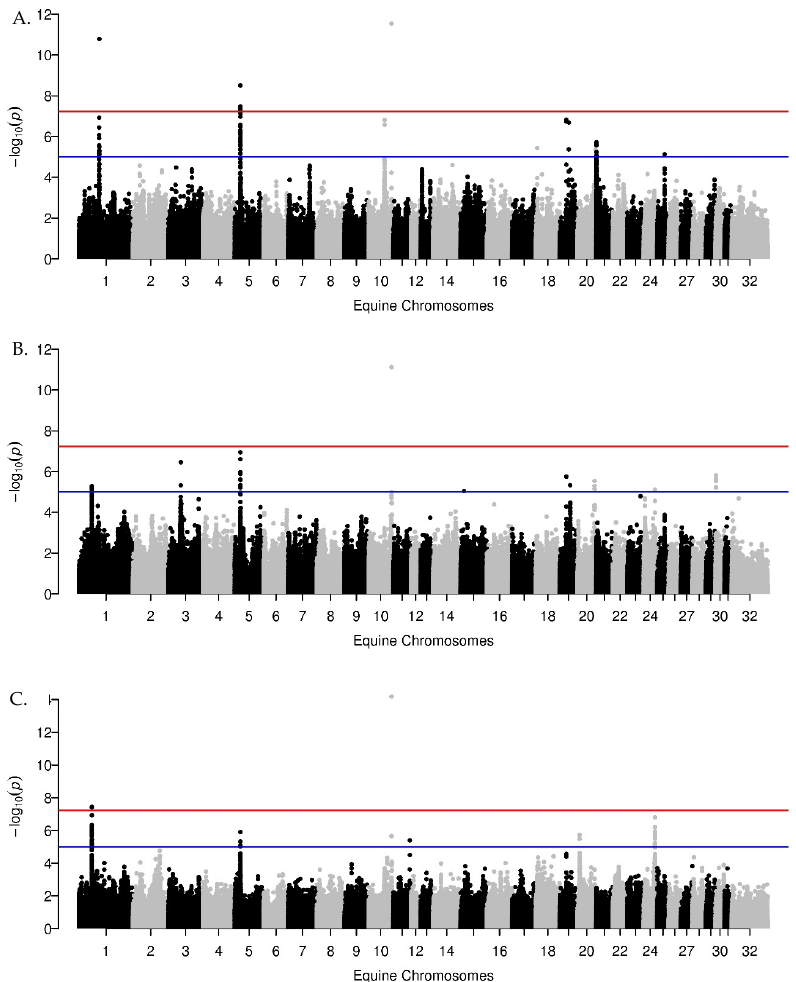
Figure A2. Manhattan plots of the genome-wide association results for ACTH in ( A ) full Welsh pony cohort, ( B ) the section A, B, C and D Welsh ponies, and ( C ) the section A and B Welsh ponies. The equine chromosomes (ECA) are plotted on the x-axis and the − log10 of the p -value is plotted on the y-axis. The blue line indicates the suggestive threshold (1.0 × 10 − 05 ) and the red line represents the genome-wide significant threshold (5.9 × 10 − 08 ). In all three GWA, the same region on ECA5 exceeds the suggestive threshold but is only identified as an ROI in the full cohort